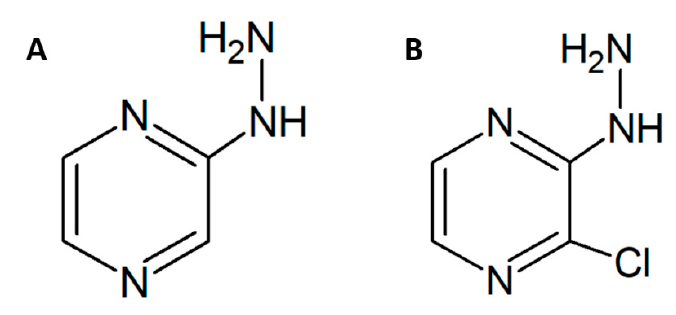
Figure 1. The structure of the 2-hydrazinopyrazine ( 2HP )—( A ), and 2-chloro-3-hydrazinopyrazine ( 2Cl3HP )—( B ).